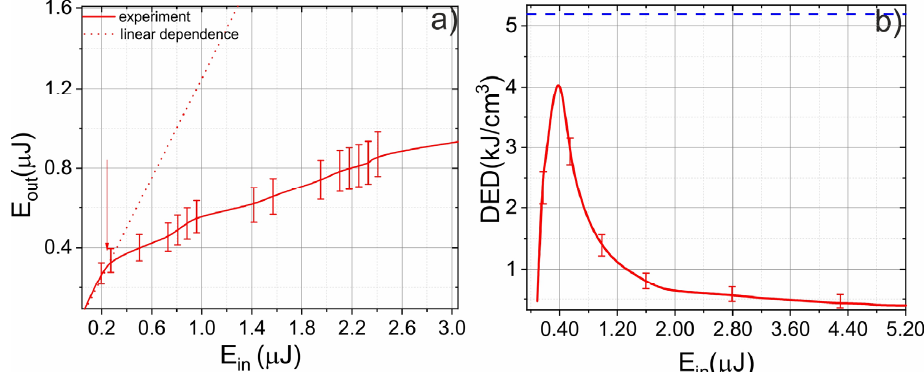
Figure 2. ( a ) Dependence of the transmitted energy on the input laser energy. The dashed line indi- cates the linear dependence and the arrow indicates the plasma-formation threshold. ( b ) Dependence of deposited energy density (DED) on the input laser energy. The dashed line indicates the threshold of the micromodification formation.